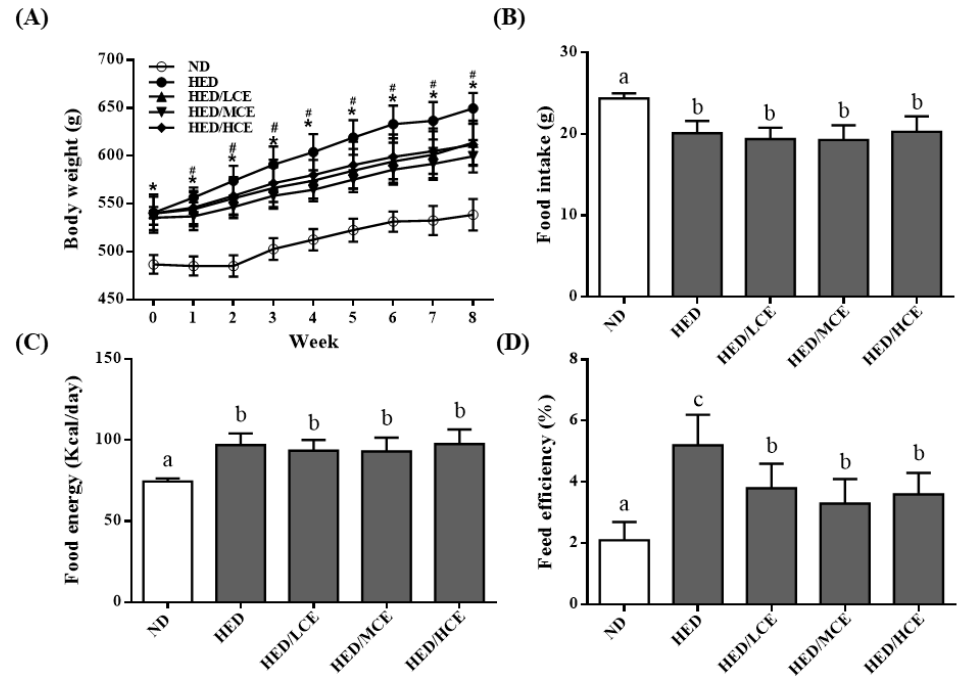
Figure 1. Effects of phlorotannin-rich extracts from A. nodosum and F. vesiculosus on ( A ) body weight, ( B ) food intake, ( C ) food energy, and ( D ) feed efficiency of rats with high-energy diet–induced hyperlipidemia. ND: normal diet; HED: high-energy diet; LCE: low dosage of crude extract; MCE: medium dose of crude extract; HCE: high dosage of crude extract. Values were presented as means ± SD (n = 10). Data were statistically analyzed using one-way ANOVA followed by a Duncan post hoc test. Different letters and symbols indicate significant differences ( p < 0.05). * p < 0.05 compared with ND; # p < 0.05 compared with HED.